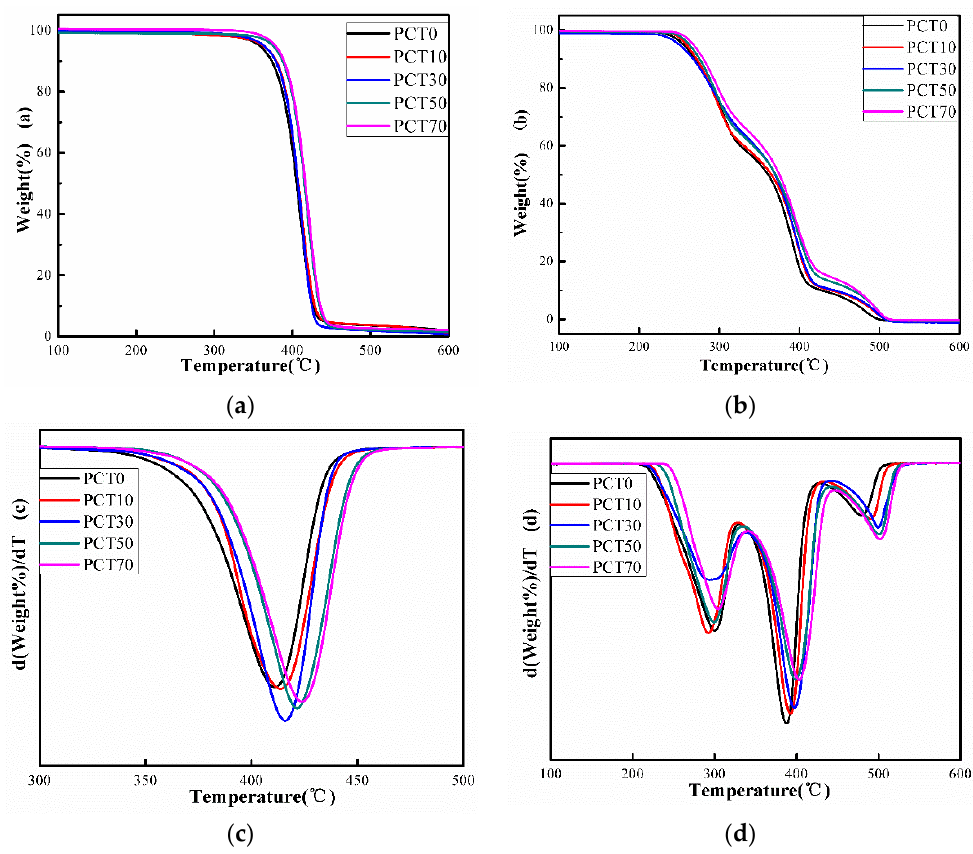
Figure 7. TGA and DTG thermograms of the (PBT-co-PCT)-b-PTMG copolymers at 20 °C min – 1 : ( a ) TGA in nitrogen atmosphere; ( b ) TGA in oxygen atmosphere; ( c ) DTG in nitrogen atmosphere; and ( d ) DTG in oxygen atmosphere.